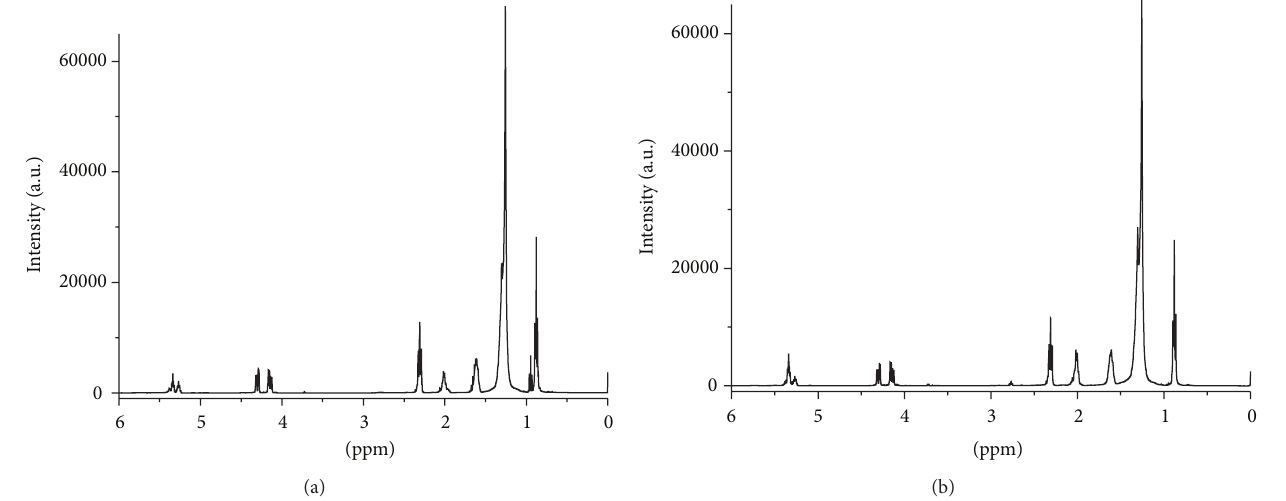
Figure 2: 1 H NMR spectra of Gouda cheese (a) compared to an imitation cheese based on vegetable fat (b).